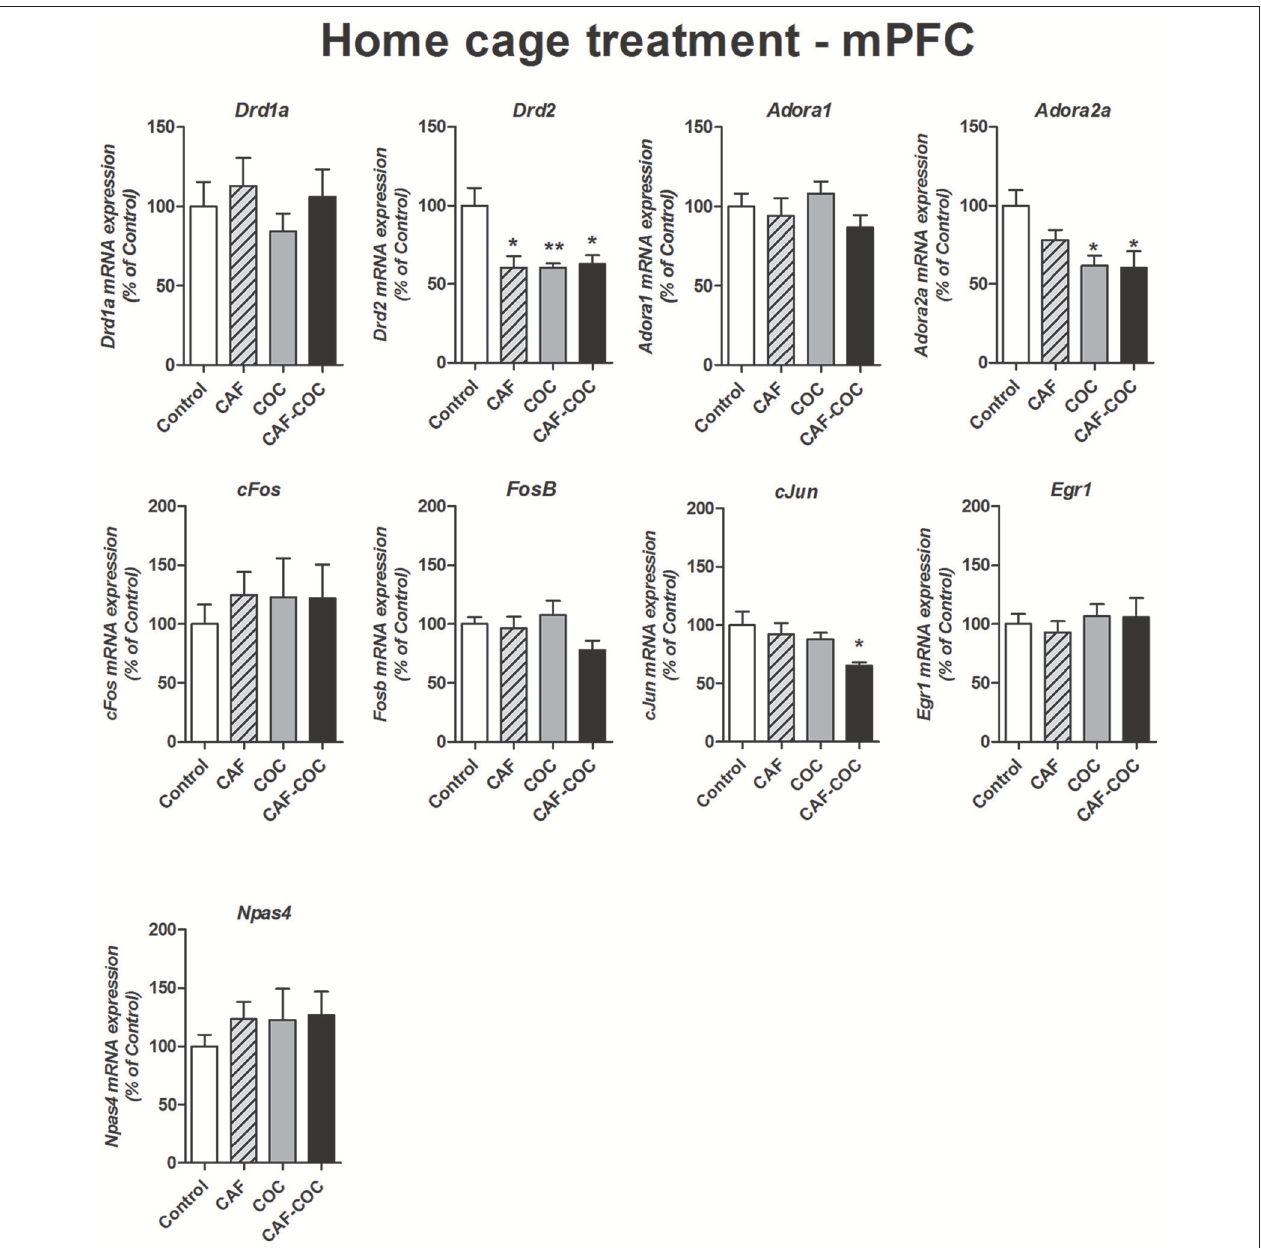
FIGURE 7 | Gene expression changes in the mPFC induced by caffeine and cocaine repeated treatment in the home cage. Dopamine receptor subunits Drd1a and Drd2 ; adenosine receptor subunits Adora1 and Adora2a ; IEGs FosB , cFos , cJun , Egr1 , Npas4 . Values indicate mean ± SEM. One-way ANOVA–Tukey: * p < 0.05, ** p < 0.01 different from